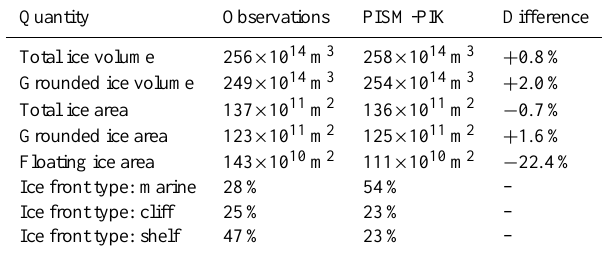
Table 1. Comparison with observations of key quantities in the PISM-PIK dynamical equilibrium simulation (Lythe et al., 2001; Le Brocq et al., 2010). The column labeled “difference” is the amount by which the model result exceeds